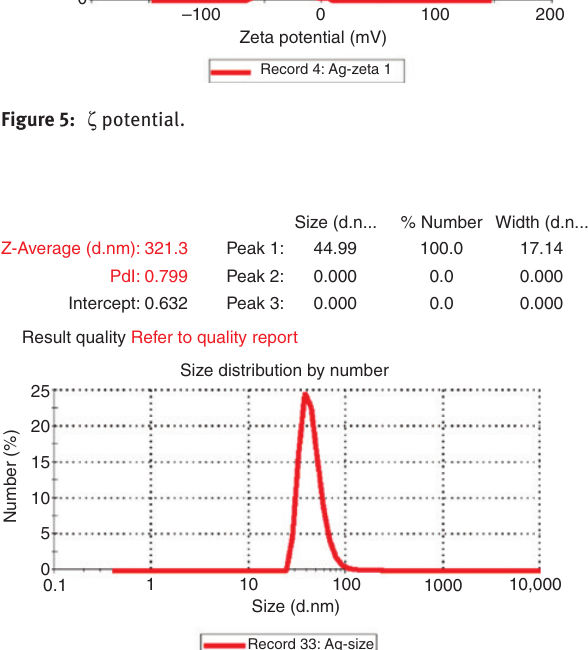
Figure 6: ζ potential – number particle size distribution.